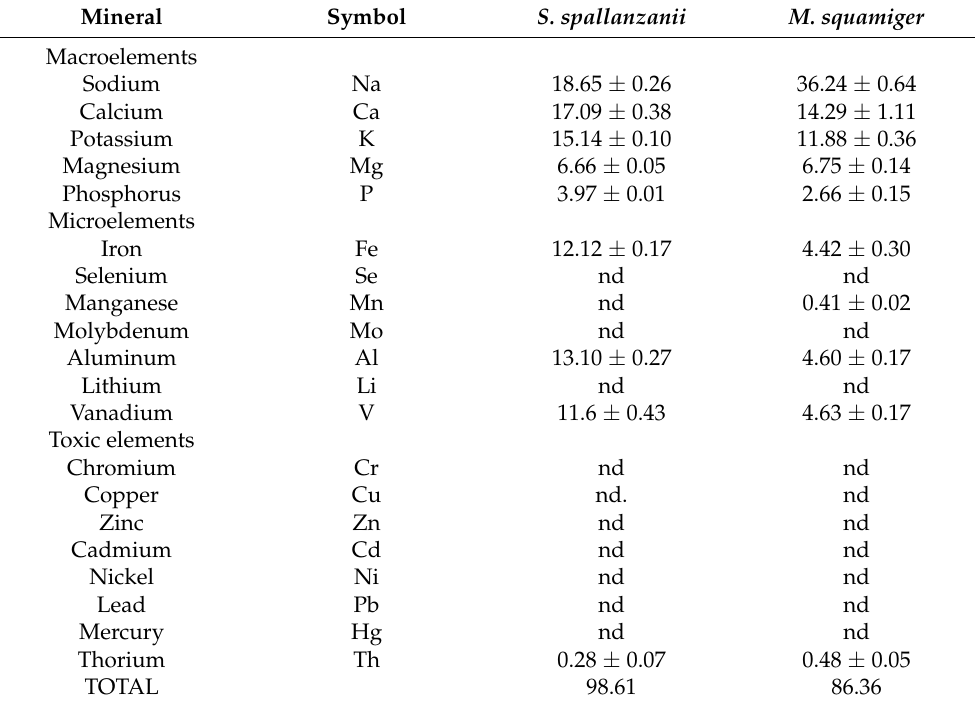
Table 3. Mineral content of Sabella spallanzanii and Microcosmus squamiger